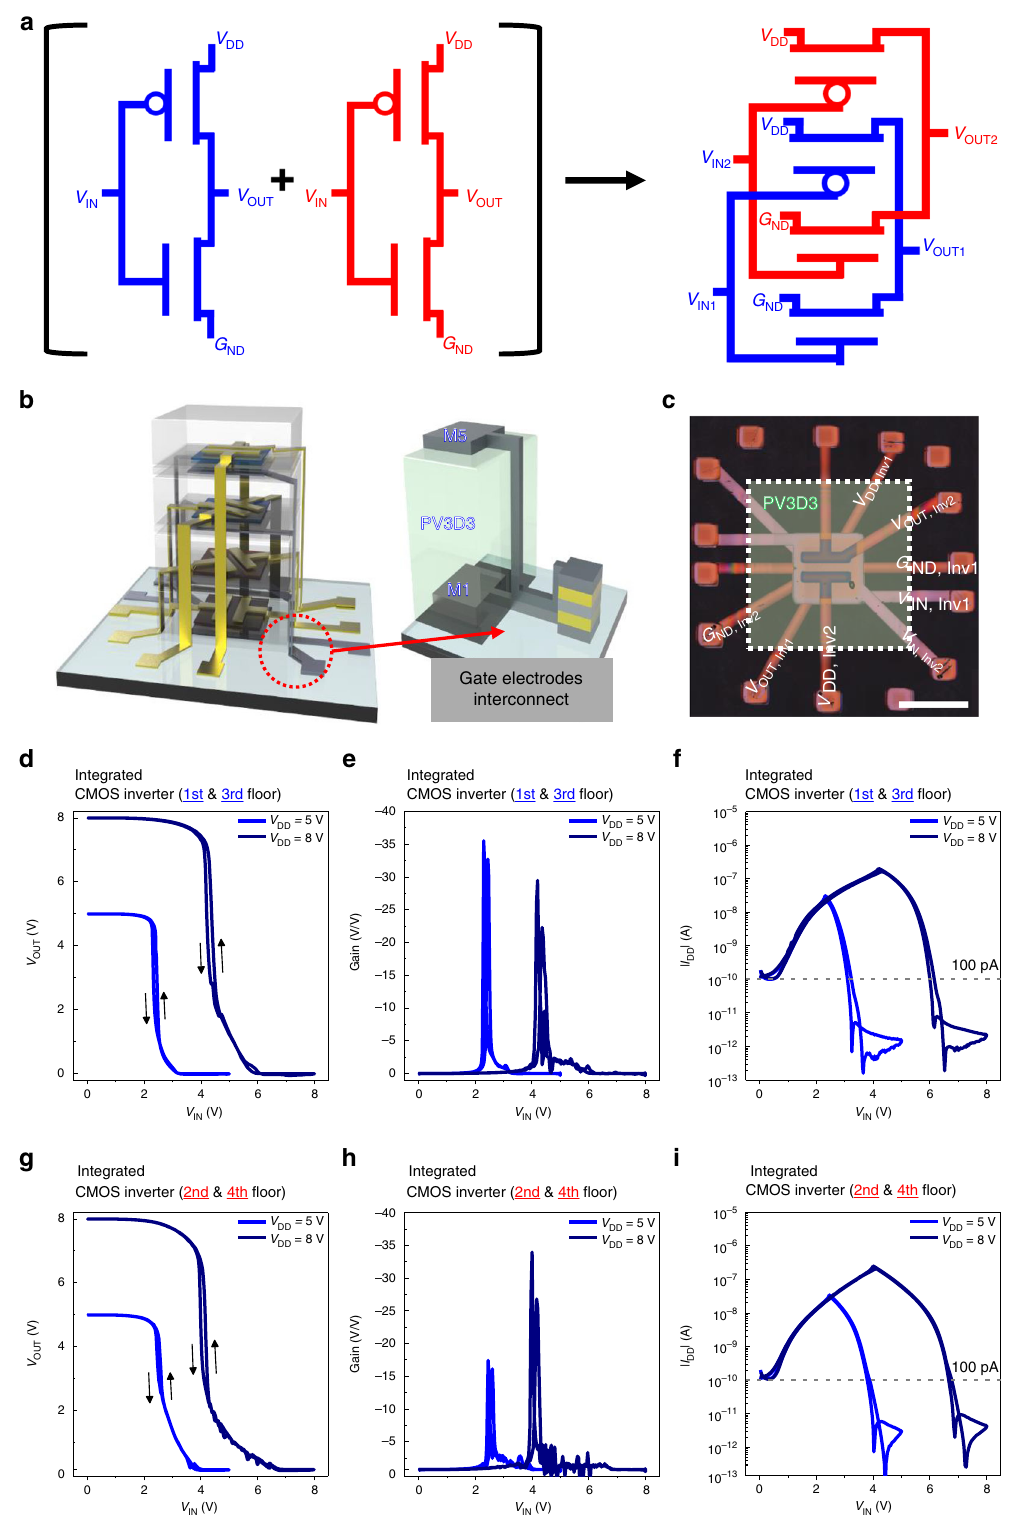
Fig. 4 Two 3D-stacked inverter circuits. a Schematic of two 3D-stacked inverter circuits and a conventional inverter circuit. b A schematic of the gate metal routing line in two 3D-stacked inverter circuits. c An optical micrograph image of two 3D-stacked inverter circuits, scale bar, 1400 µ m. d , e , f The inverter characteristics of a 3D-stacked inverter circuit integrated at 1F and 3F. Output voltage curve with respect to the input voltage value ( d ). DC gain plot with respect to the input voltage value ( e ). Leakage current plot with respect to the input voltage value ( f ). g , h , i Inverter characteristics of a 3D-stacked inverter circuit integrated at 2F and 4F. Output voltage curve with respect to the input voltage value ( g ). DC gain plot with respect to the input voltage value ( h ). Leakage current plot with respect to the input voltage value ( i